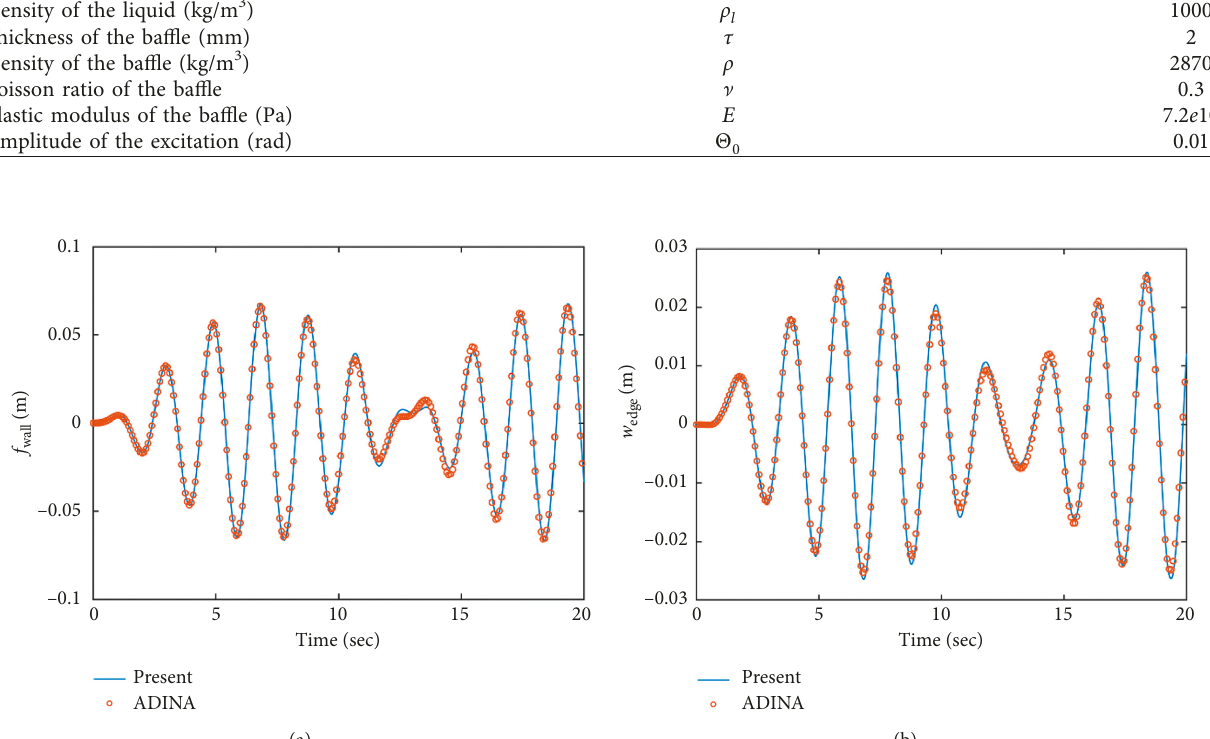
Figure 3: The time histories of the surface wave height on the wall ( θ � 0) and the dynamic deflection of the baffle at the inner edge ( θ � 0) � 3rad/s. (a) surface wave height on the wall, (b) dynamic deflection of the baffle at the inner edge. for ω 0